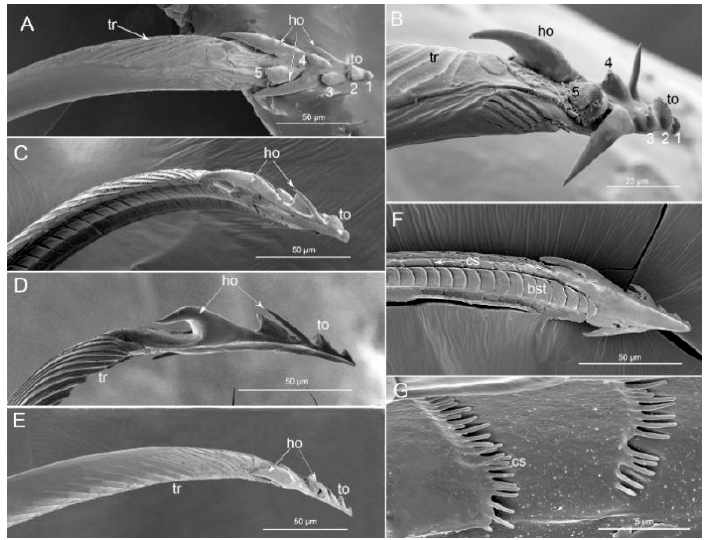
Figure 10. SEM images of mandibular stylets of three species. ( A ) External view of stylet in Picromerus bidens showing transverse ridges (tr), five irregular teeth (to) and three long and pointed hooks (ho); ( B ) External view of stylet in Picromerus bidens ; ( C ) Lateral view of stylet in Picromerus bidens ; ( D ) Lateral view of stylet in Picromerus lewisi ; ( E ) Lateral view of stylet in Cazira bhoutanica ; ( F ) Interior side of stylet of Cazira bhoutanica showing small cuticular spines (cs) and big squamous textures (bst); ( G ) Small cuticular spines (cs); 1–5, irregular teeth.